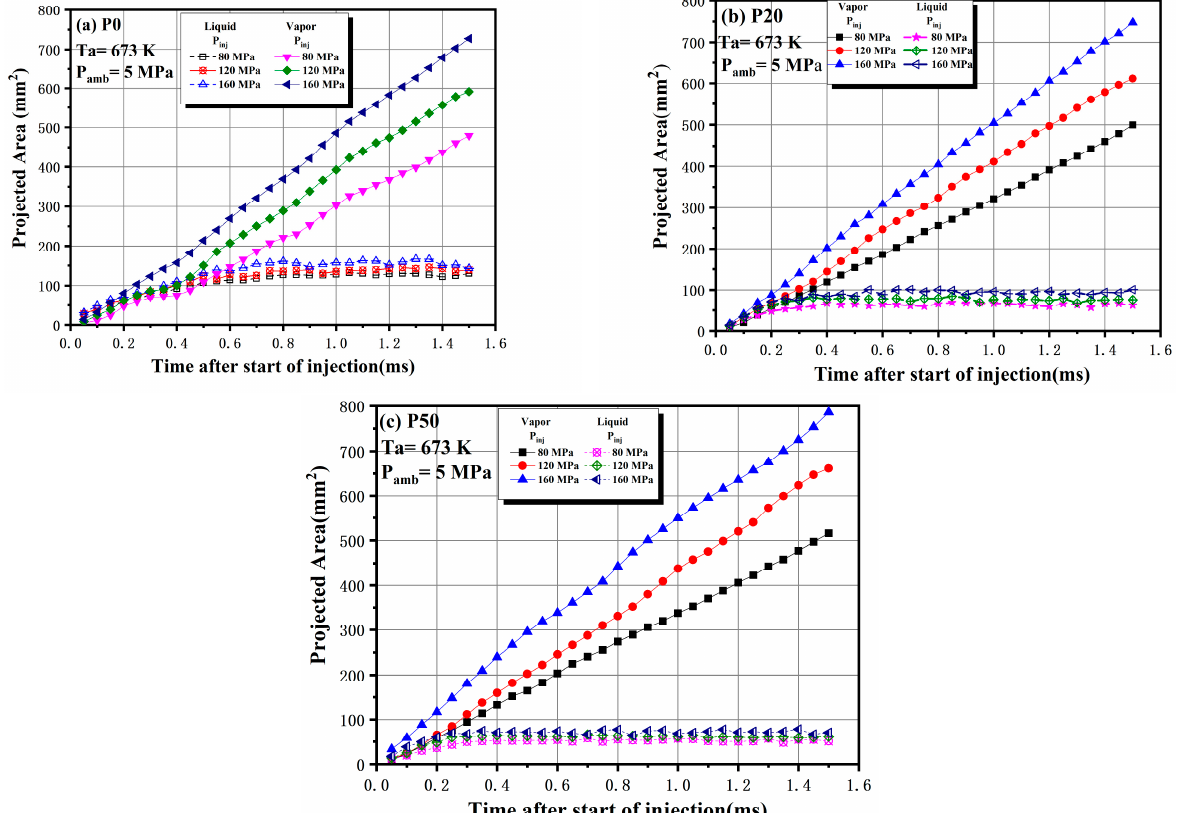
Figure 14. Projection area of the three fuels under different fuel IPs: ( a ) P0, ( b ) P20, ( c ) P50.